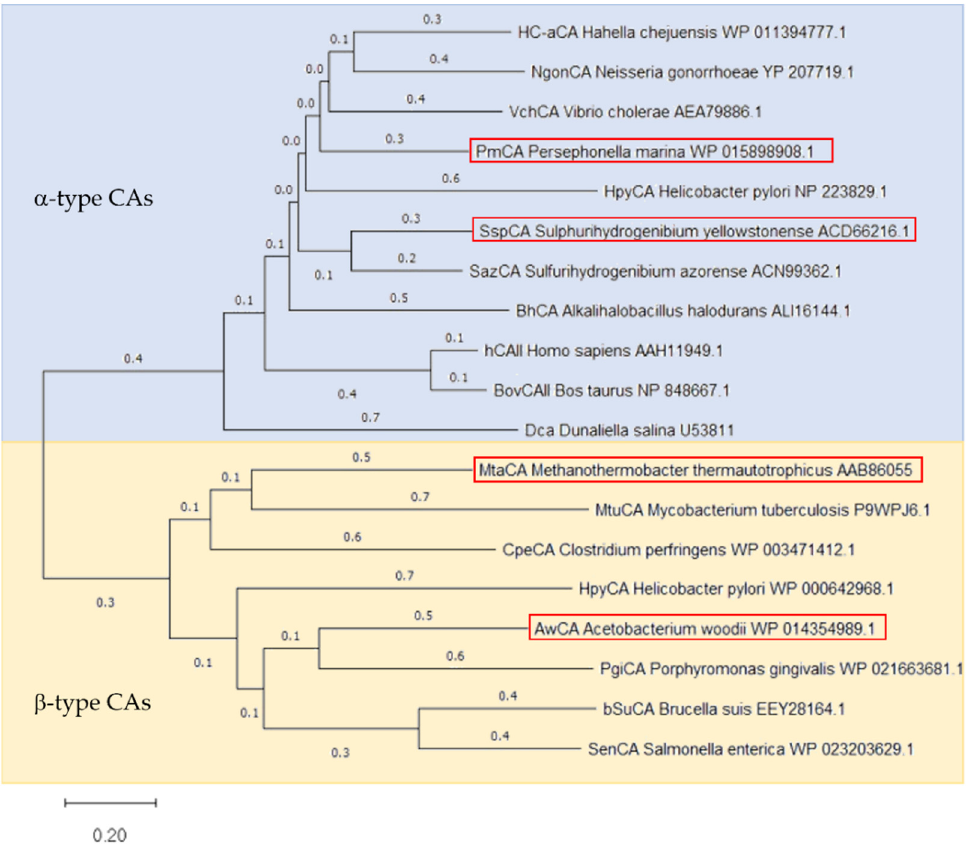
Figure 1. Phylogenetic tree of α -type and β -type CAs. Phylogenetic tree was constructed by MEGA11 software employing the Neighbor-joining Method [39] based on the protein sequences of CAs used in this study (highlighted by a red frame) as well as CAs described in literature. The blue background indicated α -type CAs, the yellow one the β -type CAs. The protein sequences are named by their Cryptonym followed by the microorganism’s name and the NCBI accession number. The bar at the bottom provides the scale of the branch lengths.